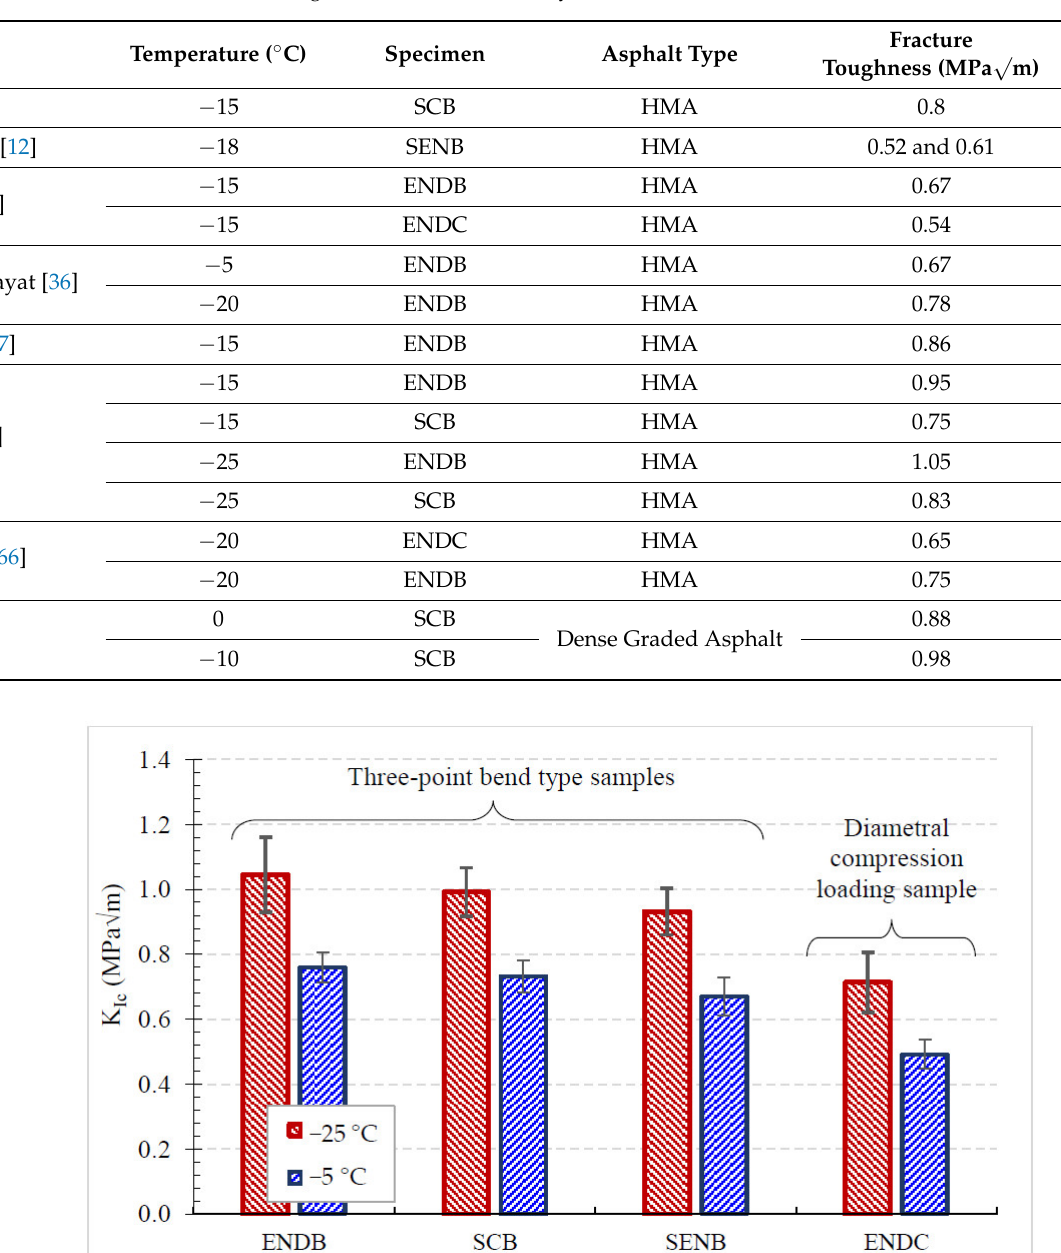
Table 5. Mode I fracture toughness values obtained by different researchers.